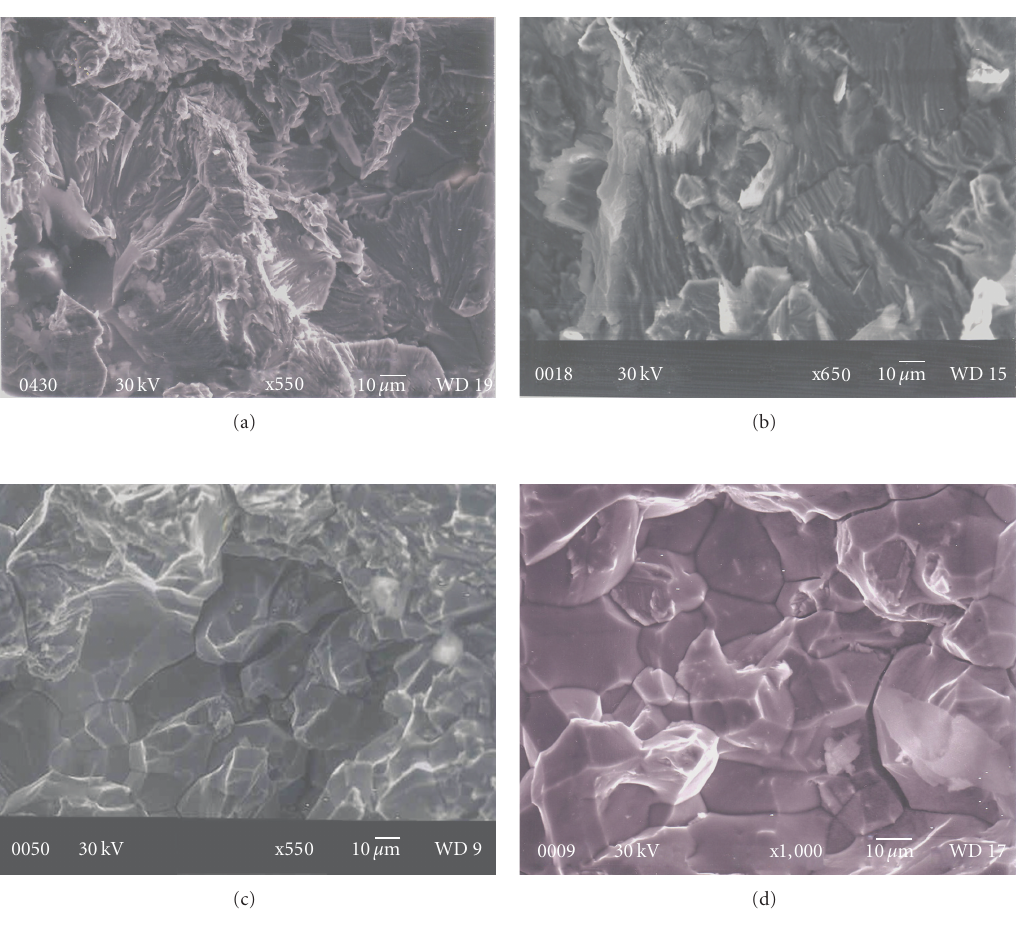
Figure 5: Fracture appearances for (a) type 304 at T = 416 K and σ = 300 MPa; x550 (b) for type 310 at T = 416 K and σ = 300MPa; x650, (c) for type 316 at T = 408K and σ = 300 MPa; x550 and (d) for type 316 at T = 408 K and σ = 400MPa; x1000 in boiling saturated MgCl 2